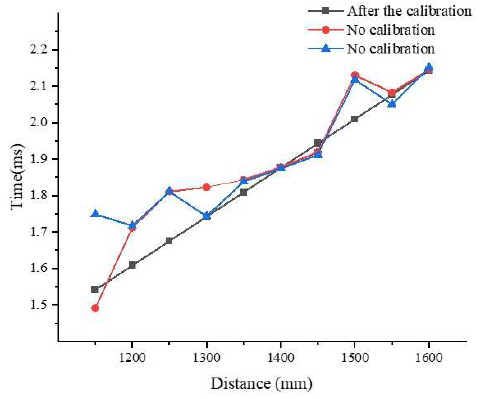
Figure 12. Comparison of data of transducer No. 2 before and after calibration.